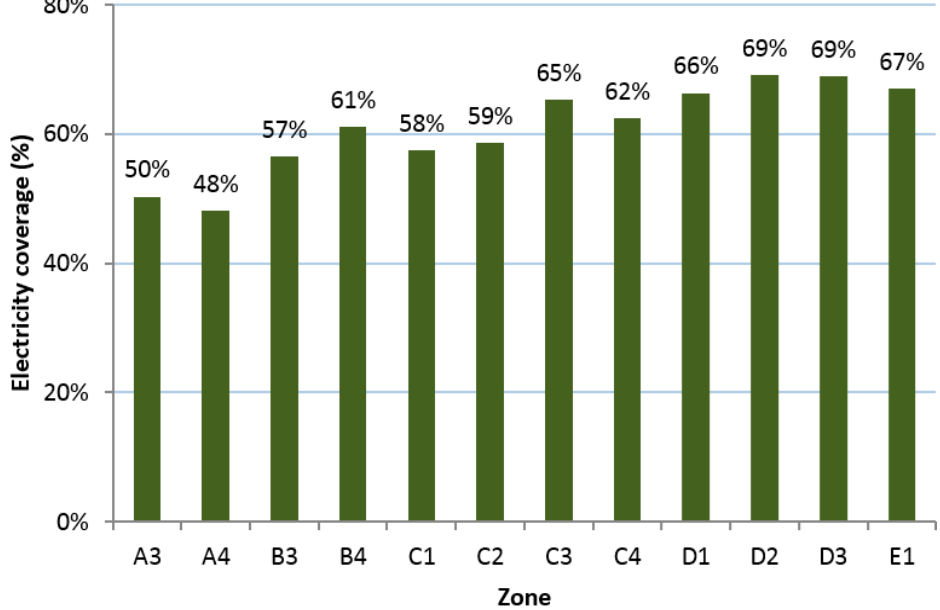
Figure 13. Annual electricity coverage comparison for the different climatic zones.